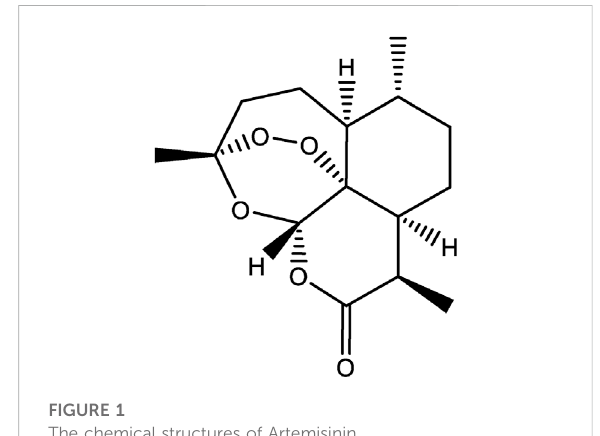
FIGURE 1 The chemical structures of